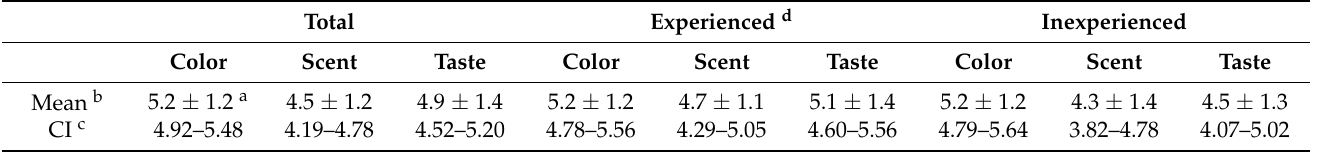
Table 3. Attribute test of how OF sample differs from APV sample in color, scent, and taste. Total Experienced d